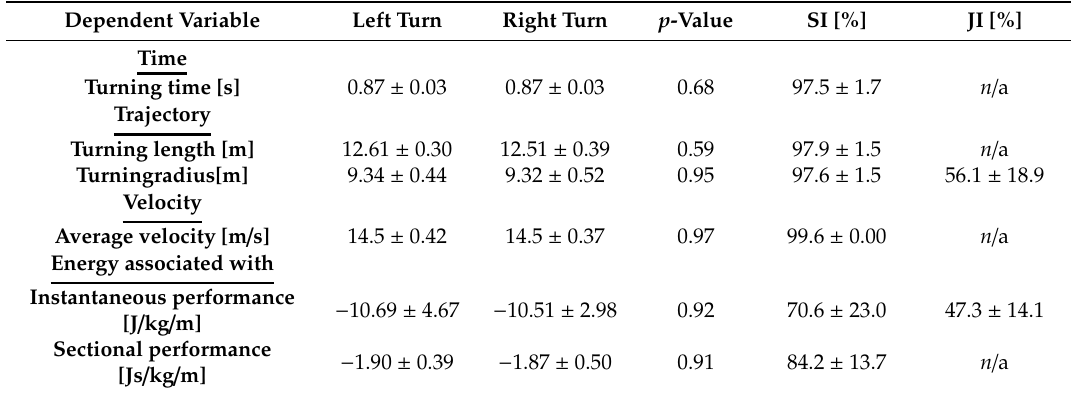
Table 2. The time, trajectory, velocity and energy dissipation during left and right turns by elite slalom skiers, together with the corresponding symmetry (SI) and Jaccard indices (JI) (dependent variables). All values presented are means ± standard